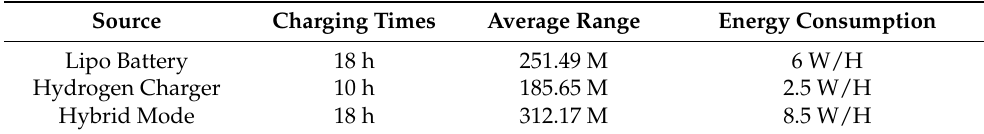
Table 4. Comparison of the energy consumption for three type of fuels present. Source Charging Times Average Range Energy